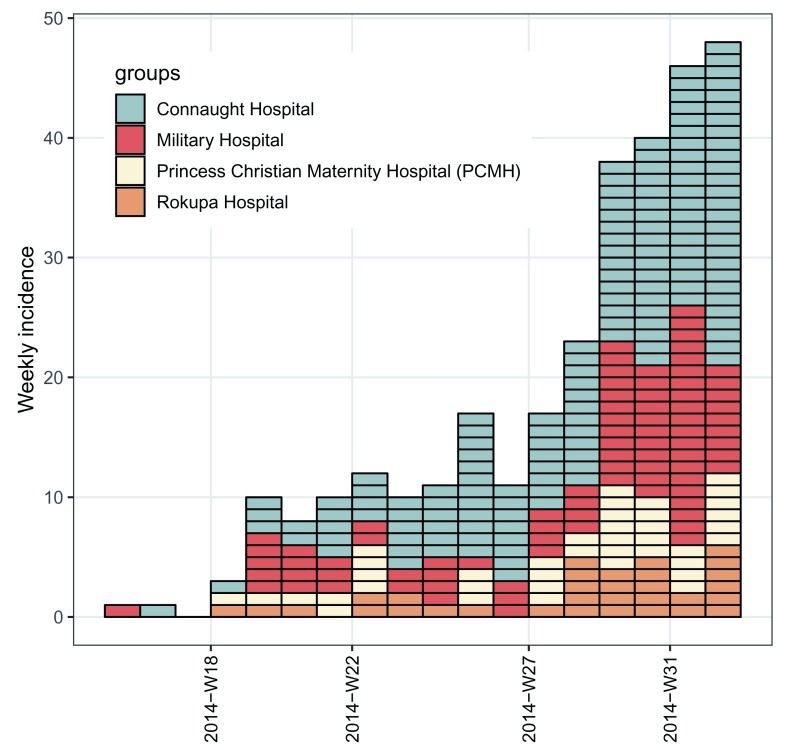
Weekly epicurves stratified by hospitals representing the first eight weeks of simulated outbreak of EVD.